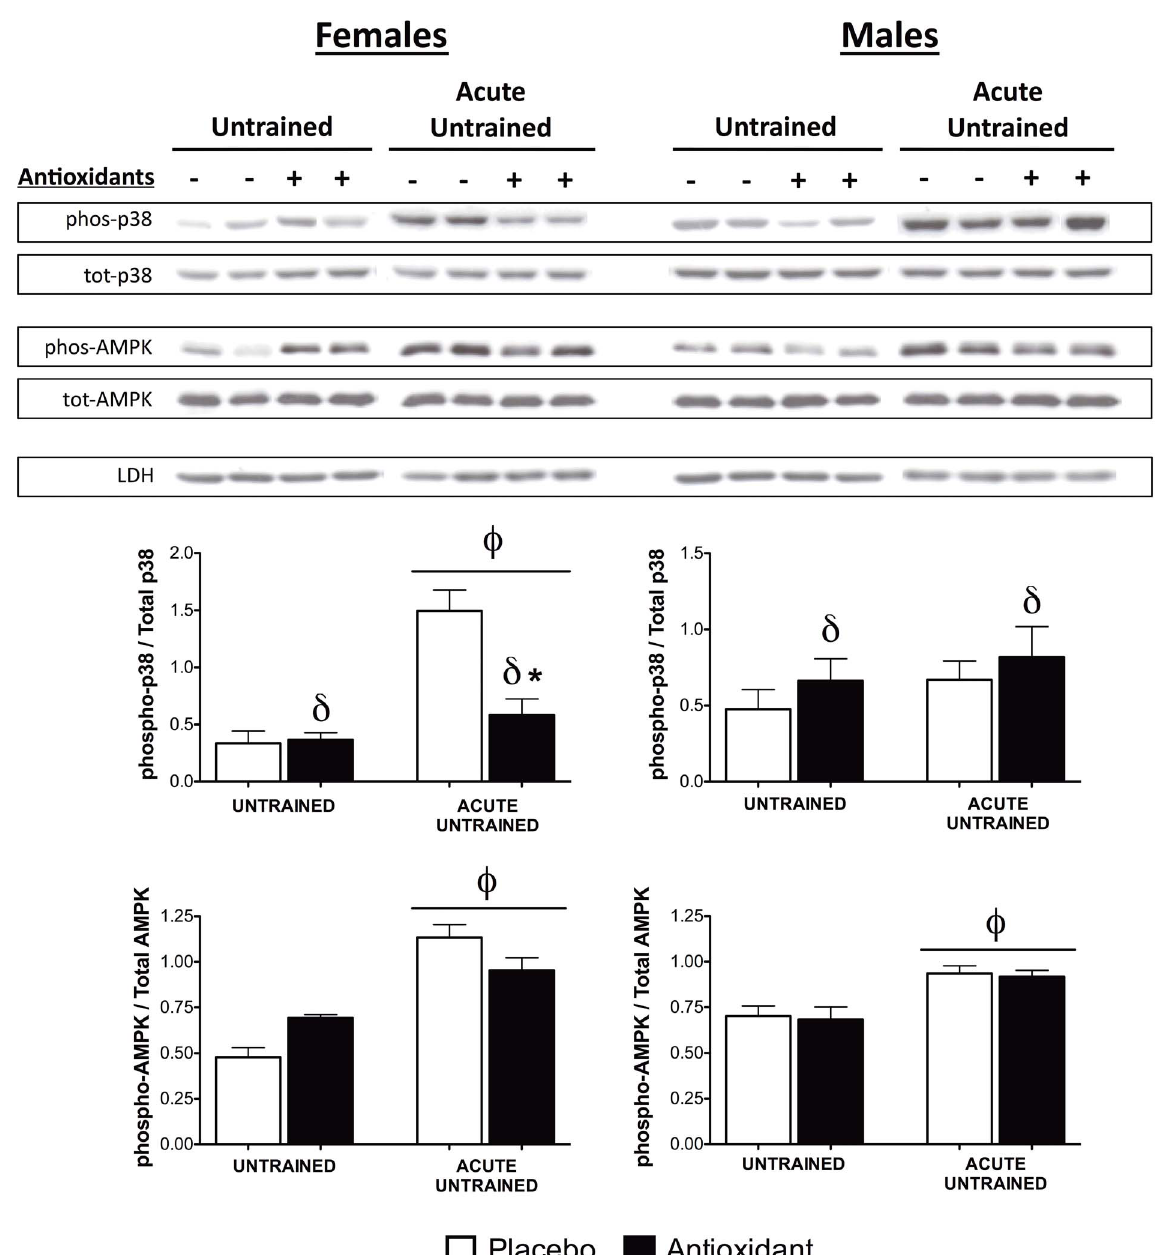
Figure 5. Activation of signaling kinases. Protein expression of total-p38 MAPK, phospho-p38 MAPK (Thr180/Tyr182), total-AMPK, and phospho- AMPK (Thr172) was determined as in Figure 3. The ratio of phosphorylated bands to total bands was determined and plotted. w indicates a significant (p # 0.05) main effect of exercise, d indicates a significant (p # 0.05) main effect of antioxidant supplementation, and post-hoc testing was used to compare antioxidant- and placebo-supplemented groups, * indicates p #